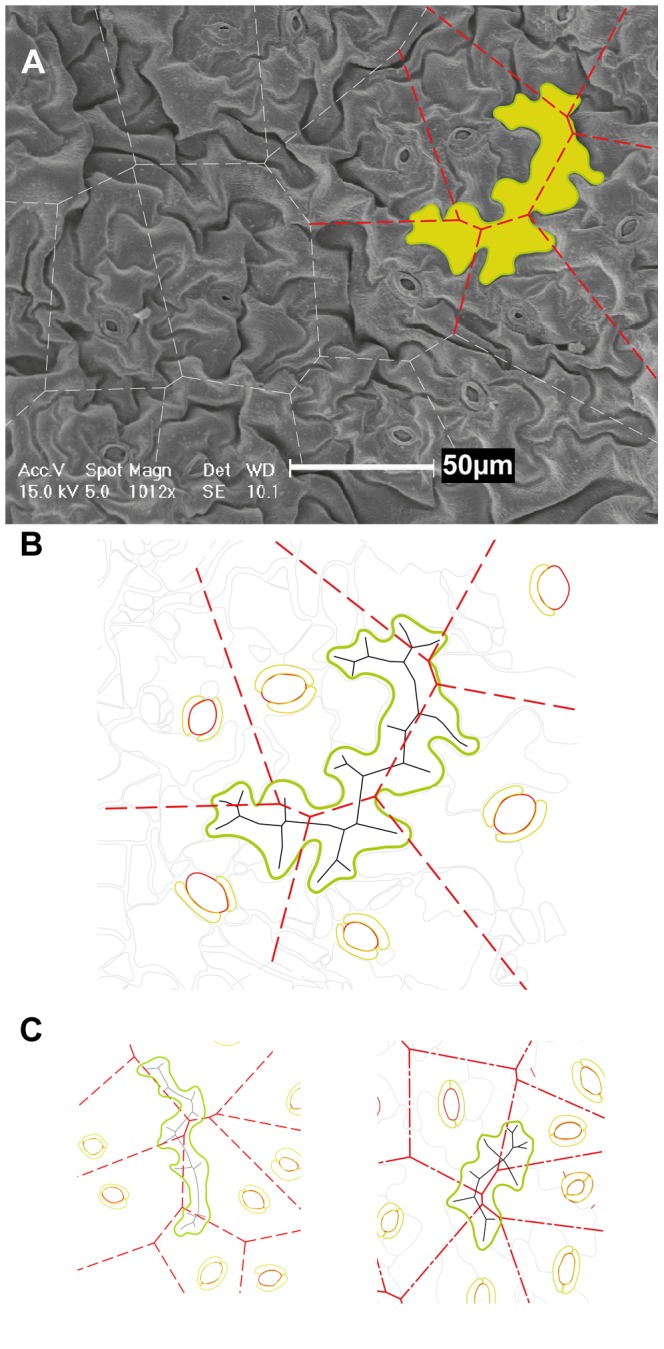
SEM image with giant pavement cell highlighted.A SEM image taken from the day 24 series with a giant cell outlined in green. B Giant pavement cell as identified in A: cell boundary (green line); medial axis transform (MAT; black lines); Voronoi cell boundaries (red dashed lines) calculated using centroid of stomatal complex as input coordinates; stomatal pores and guard cells (shown in red and yellow). Cell area = 1575 µm2, cell perimeter = 333 µm; area∶perimeter ratio = 4.7; average MAT angle is 139.4° for the largest angles and 110.3° for the smaller two of three angles. C Example (left), from day 24 data, of giant cell sitting along the Voronoi boundaries. Cell area = 1032; cell perimeter = 242; area∶perimeter ratio = 4.3; length∶width ratio = 3.2. Example (right) from a young leaf.